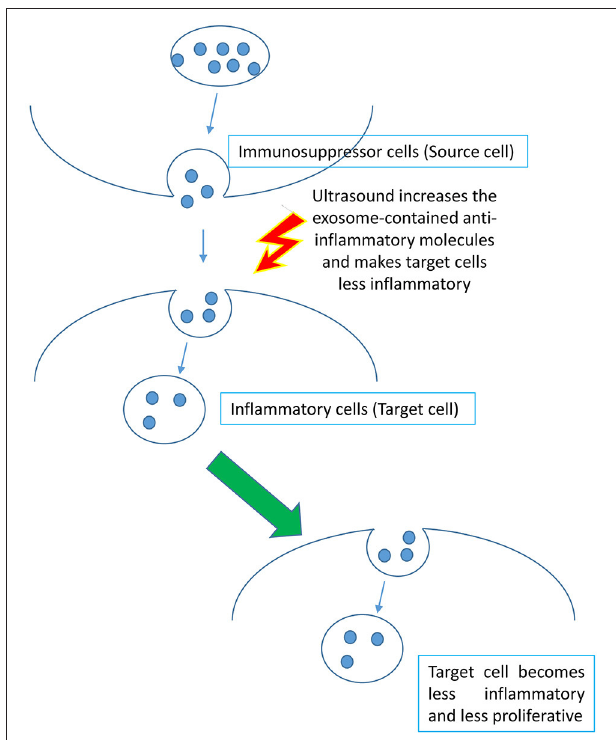
FIGURE 7 | Schematic representation of the hypothesis that increased exosome biogenesis and docking release anti-inflammatory components to the insonated media and target cells resulting in suppression of